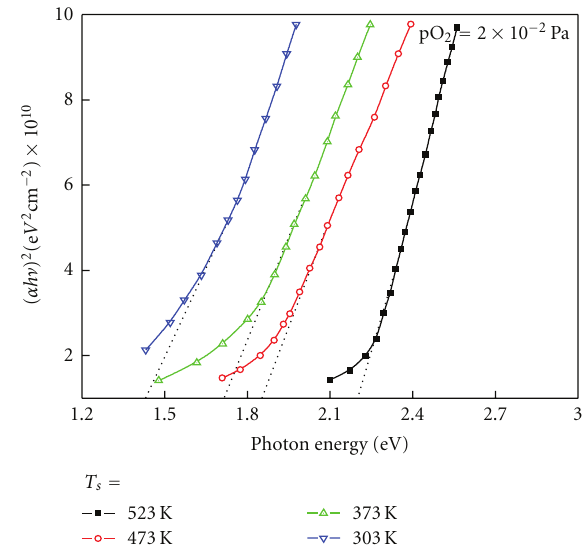
Figure 9: Plots of ( αh ν ) 2 versus photon energy ( h ν ) of Ag-Cu-O films formed at di ff erent substrate temperatures: (Ts = --- (cid:3) 116— 303 K, --- (cid:4) ---373K, --- ◦ ---473 K, --- (cid:5) ---523